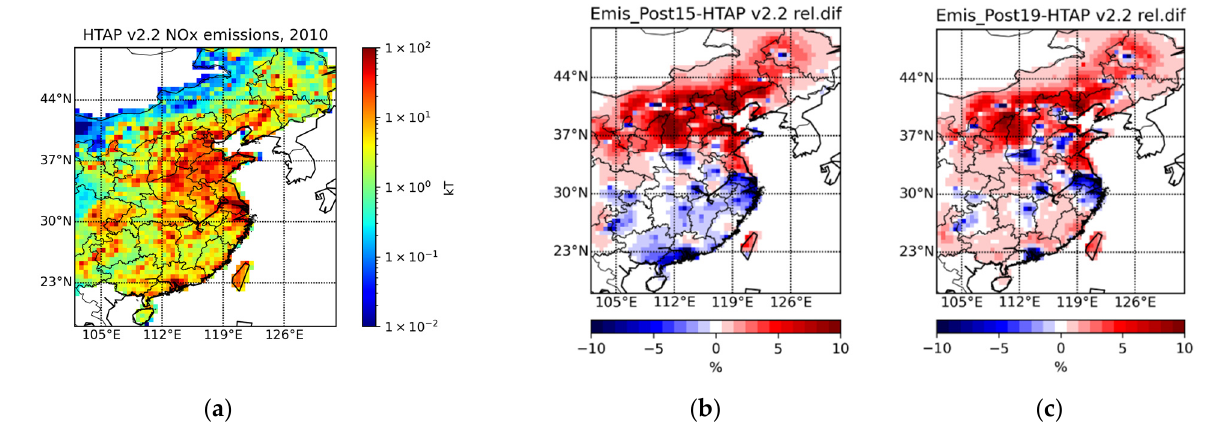
Figure 6. ( a ) NO x emissions at 0.5° × 0.5° resolution for 2010 from the HTAP v2.2 inventory in kt; Relative differences of NO x emissions for between 2010 and ( b ) 2015 and ( c ) 2019, respectively.